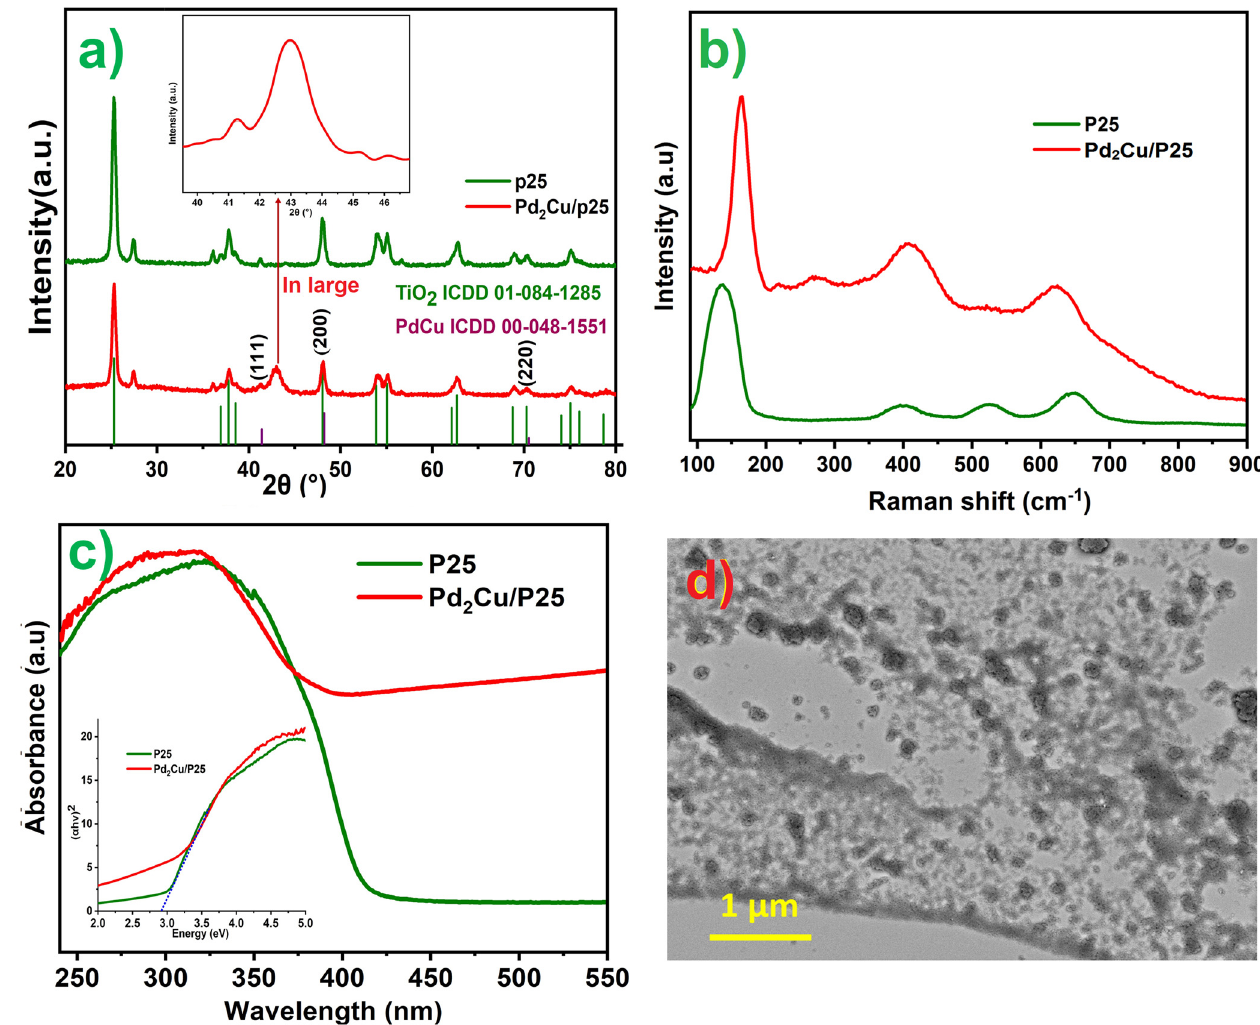
Figure 1. ( a ) XRD pattern, ( b ) Raman spectra ( c ) UV − Vis (DRS), inset is showing Tauc plots of P25 and Pd 2 Cu/P25, ( d ) FESEM Backscattered − Electron (BSE) Image of Pd 2 Cu/P25.